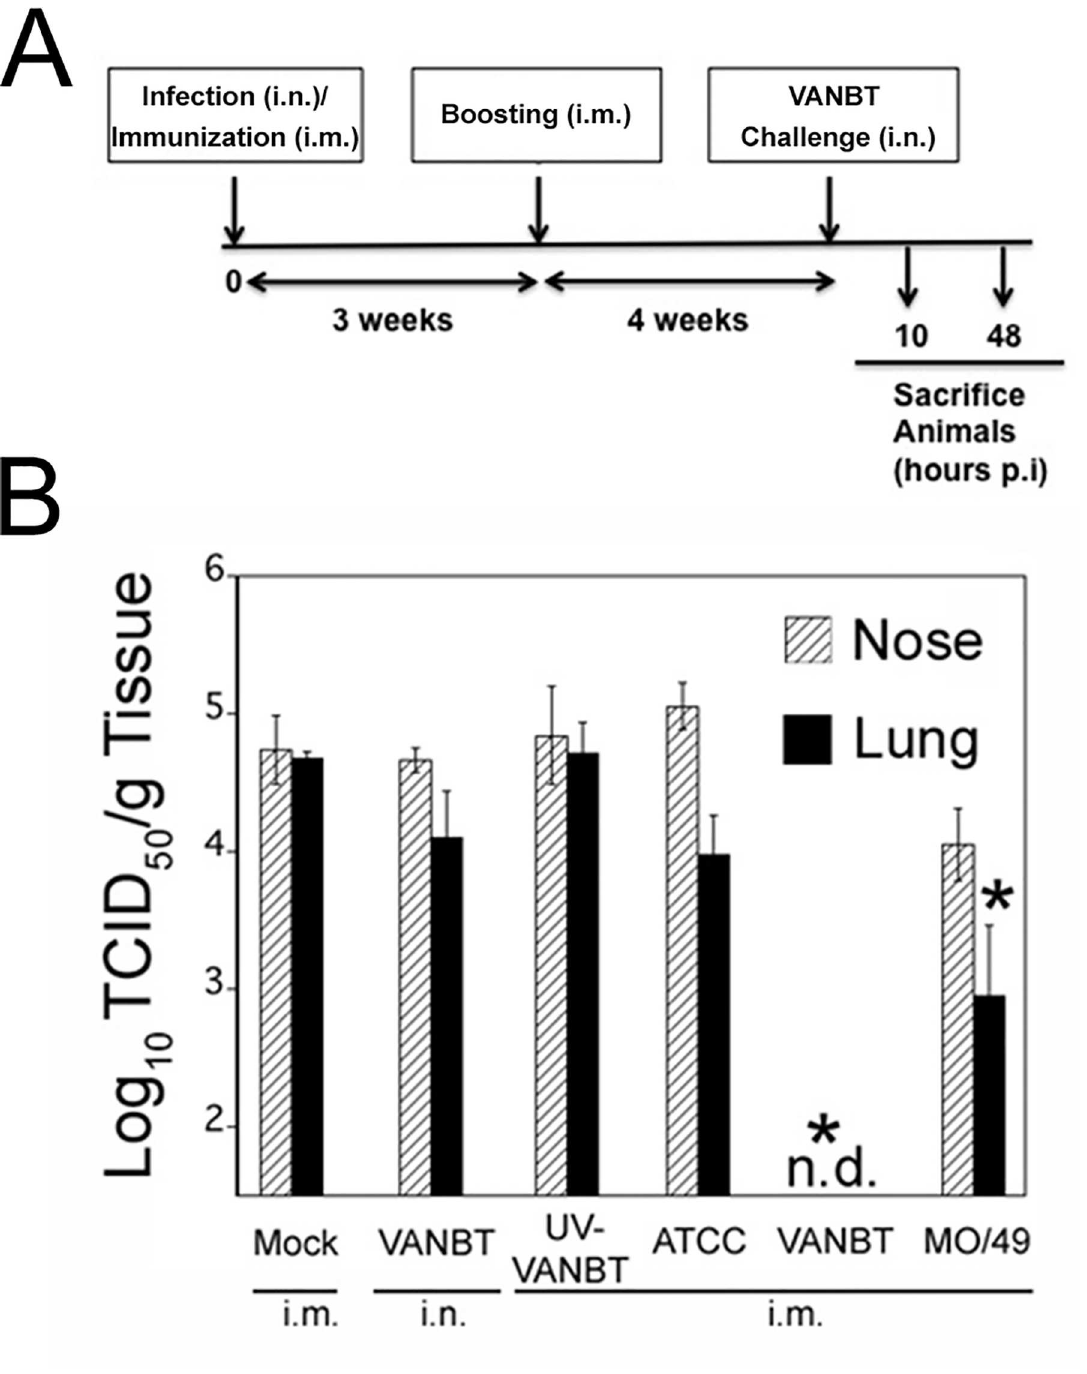
Fig 5. Intramuscular immunization with EV-D68 protects against VANBT challenge. (A) Schematic representation of infection and immunization regimen. Female cotton rats were mock-immunized i.m. on day 0 and at 3 weeks, infected with VANBT on day 0, or immunized i.m. on day 0 and at 3 weeks with UV-VANBT, ATCC, VANBT, or MO/49 using 10 6 TCID 50 / 100 μ l of virus. At 7 weeks, all animals were challengedi.n. with 10 6 TCID 50 of VANBT and sacrificed at 10 h or 48 h p.i. (B) Viral titers in the nose and lung of animals sacrificed at 10 h p.i. n = 5 per group. Data are representative of two independent experiments. * p < 0.05 where each group is compared with mock-immunized group.